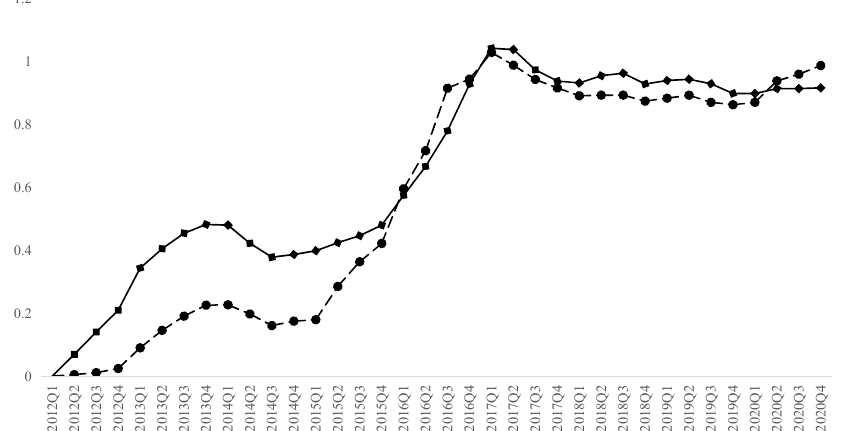
Figure 1. Historical potential prices and official housing prices. Note: The solid line in this figure